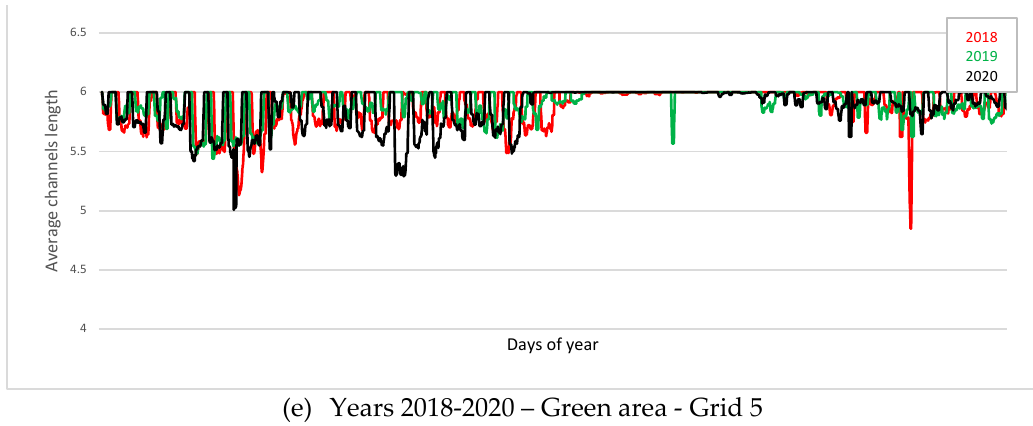
Figure 11. Results corresponding to the average length of channels constituted from 2018 to 2020 in the green geographical area under study.